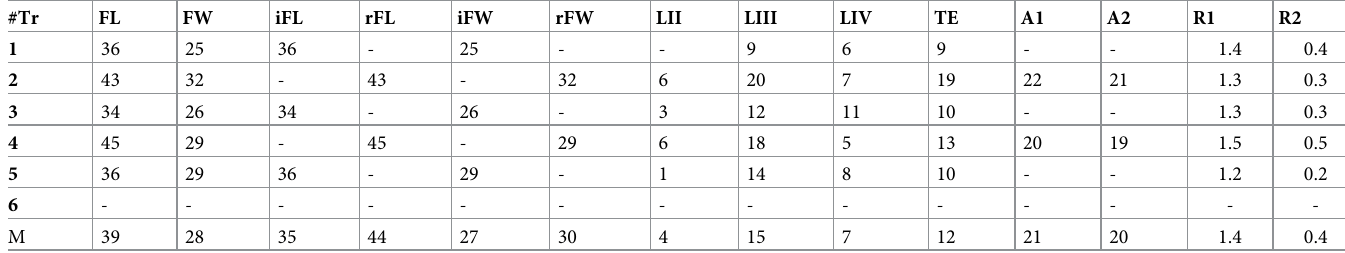
Table 3. Footprint variables.